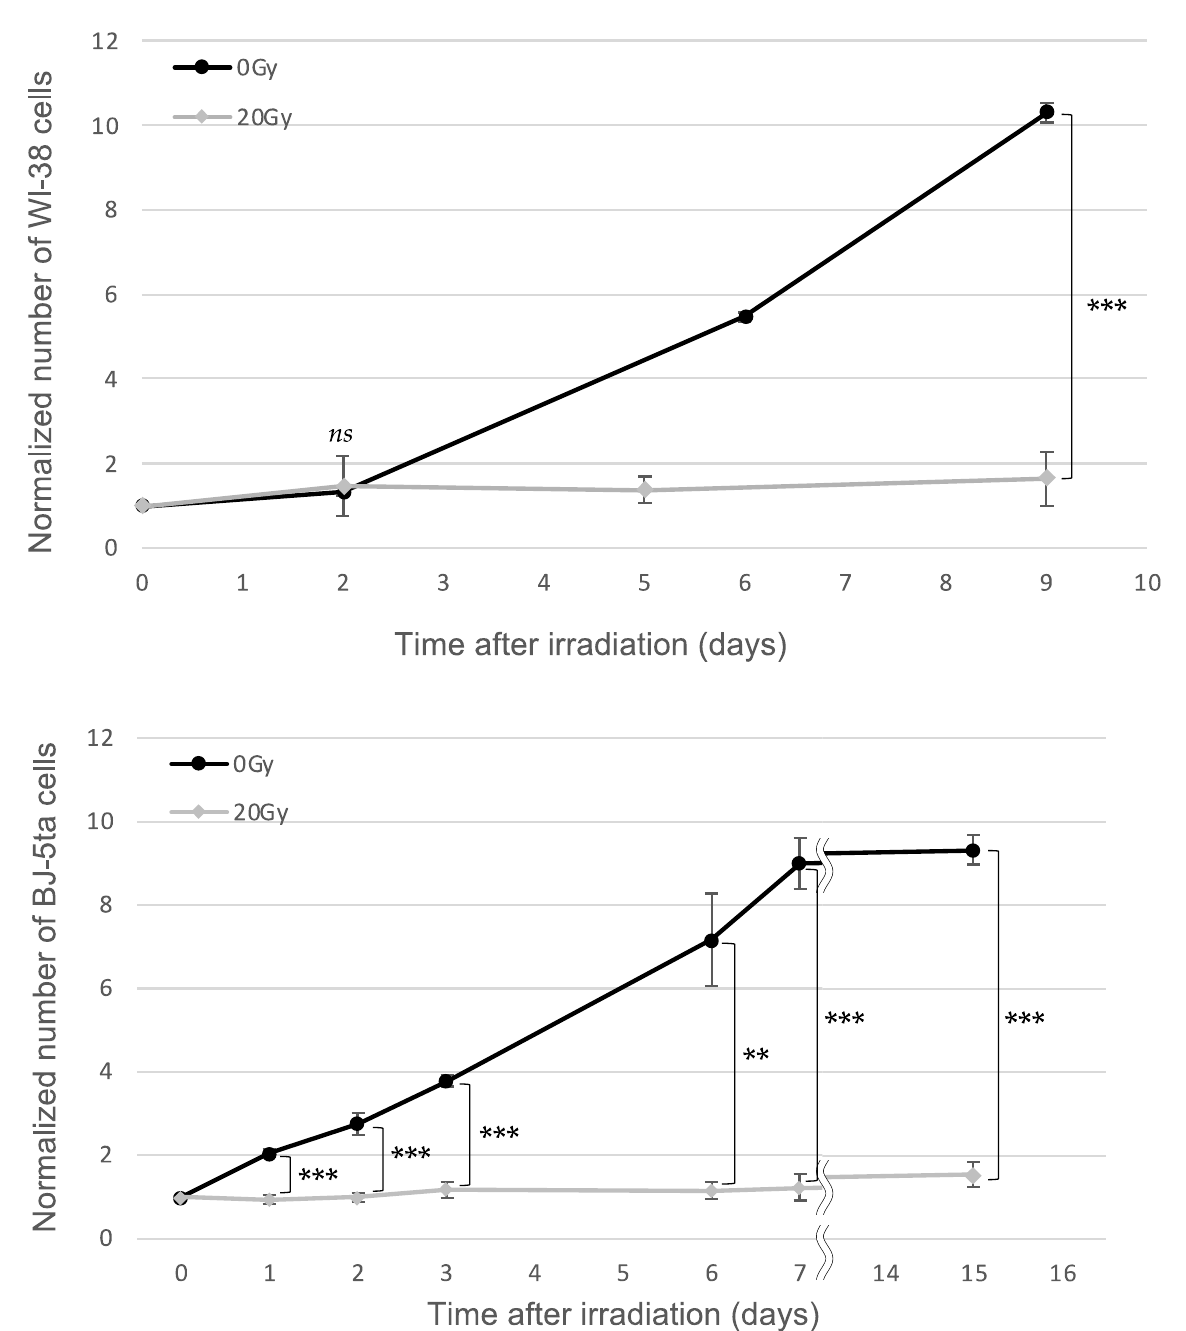
Figure 1. Cell proliferation against the X-ray dose. Nonirradiated and 20 Gy X-irradiated cells (seeded at 2.0 × 10 5 cells/well) measured over a 9-day period for WI-38 cells and a 15-day period for BJ-5ta cells. All values were normalized by the number of cells at day 0, and the error bars represent the standard deviation ( n = 3). The symbol * indicates the p -values of the Student’s t-test compared with the control and irradiated samples, respectively; *** p < 0.001, ** p < 0.01, and ns was not significant.